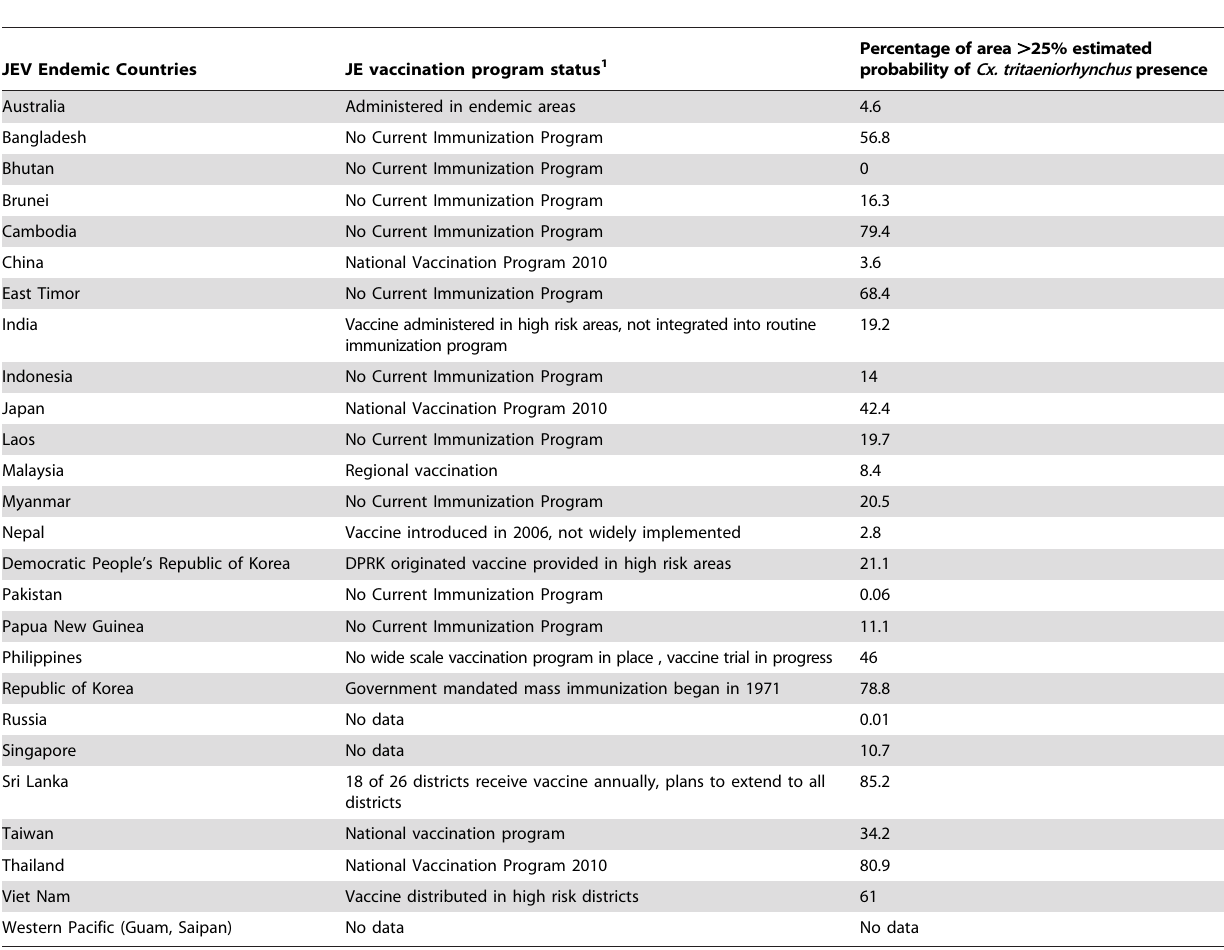
Table 1. Summary of JEV vaccination programs in endemic countries and predicted percentage of land with greater than 25% estimated probability of Cx. tritaeniorhynchus presence based on ecological niche